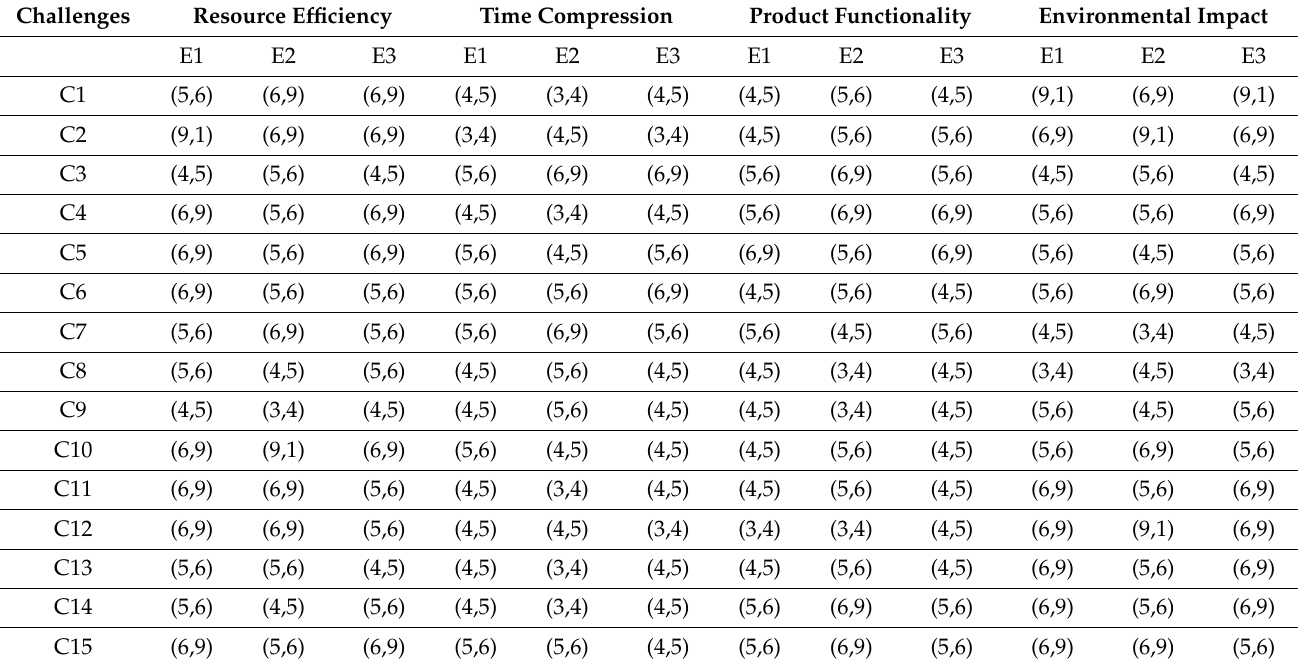
Table 4. Input rating of challenges in gray number form.